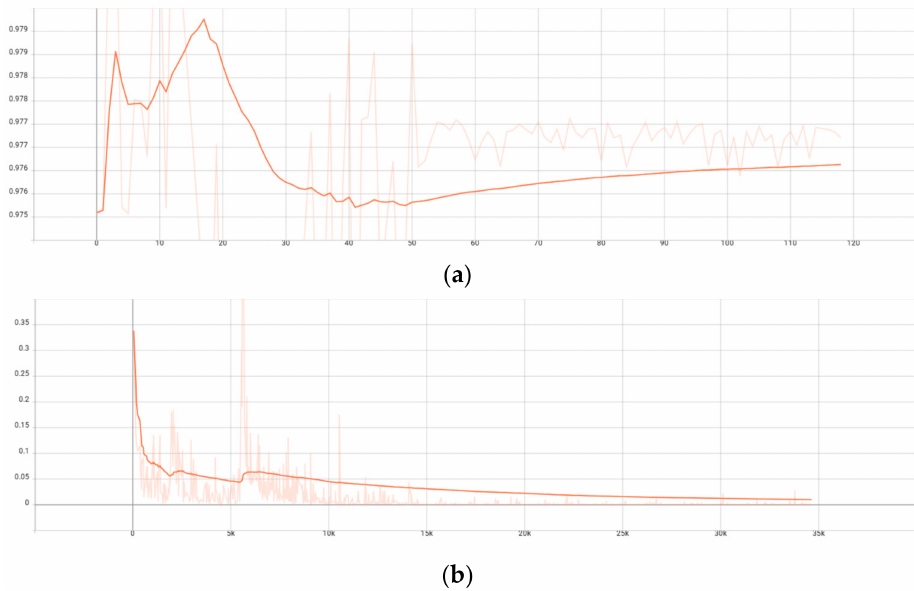
Figure 7. Classification result of MFTR-Net. ( a ) Accuracy flow chart of MFTR-Net, ( b ) Loss flow chart of MFTR-Net.